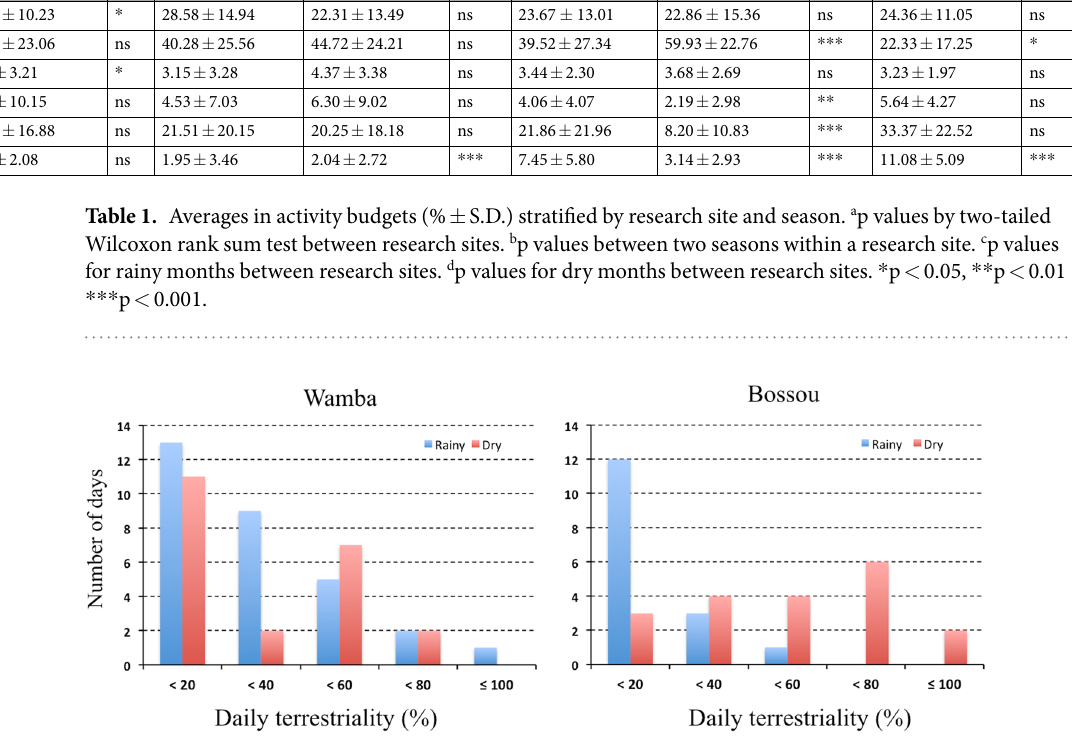
Figure2. Seasonal diffence in the frequency of daily terrestriality (%). Blue bars: rainy months. Red bers: dry